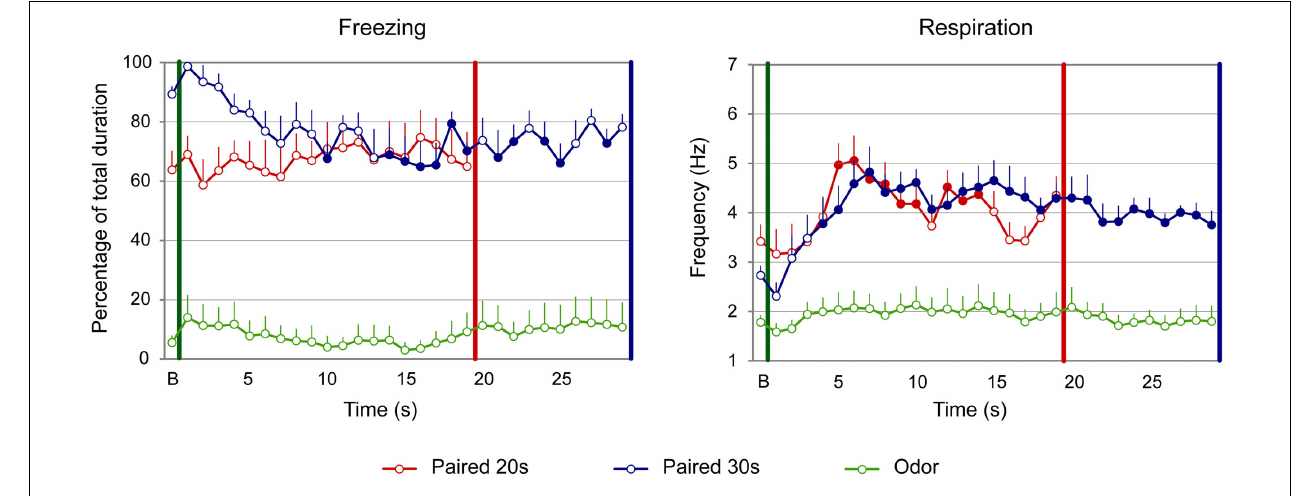
FIGURE 3 | Effect of odor-shock conditioning on fine-grain temporal pattern of freezing and respiration during odor presentation in adult rats. The temporal pattern is represented with a 1-s bin precision, from the odor onset (green vertical line on each graph) to shock arrival (red and blue